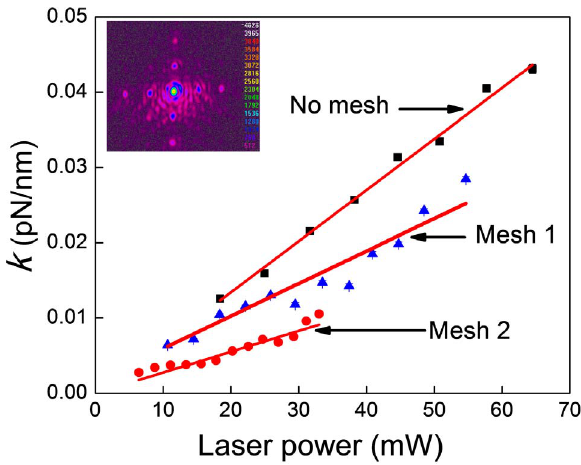
Figure 6. Radial trap stiffness as a function of increasing laser power for different meshes. The inset shows the beam profile of the focus spot when a mesh of size 178 m m 6 178 m m (Mesh 1) was inserted in the beam path. The apparent ‘‘noise’’ around the central spot is attributed to inevitable diffraction effects arising from the periodic apertures presented by the